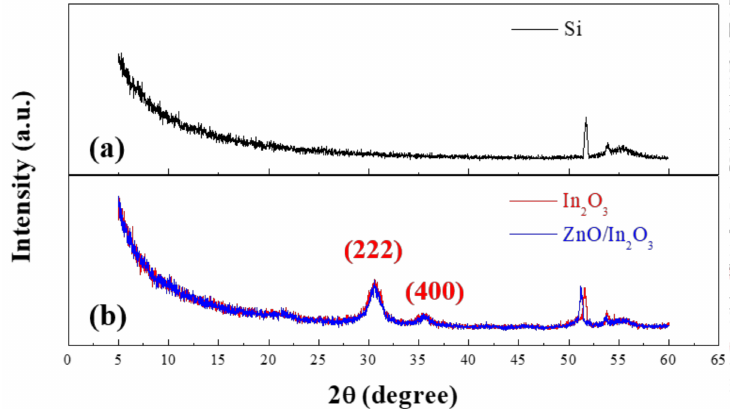
Figure 4. Grazing incidence X-ray diffraction patterns (GIXRD) patterns of ( a ) Si wafer; ( b ) single-layer In 2 O 3 , and bilayer ZnO/In 2 O 3